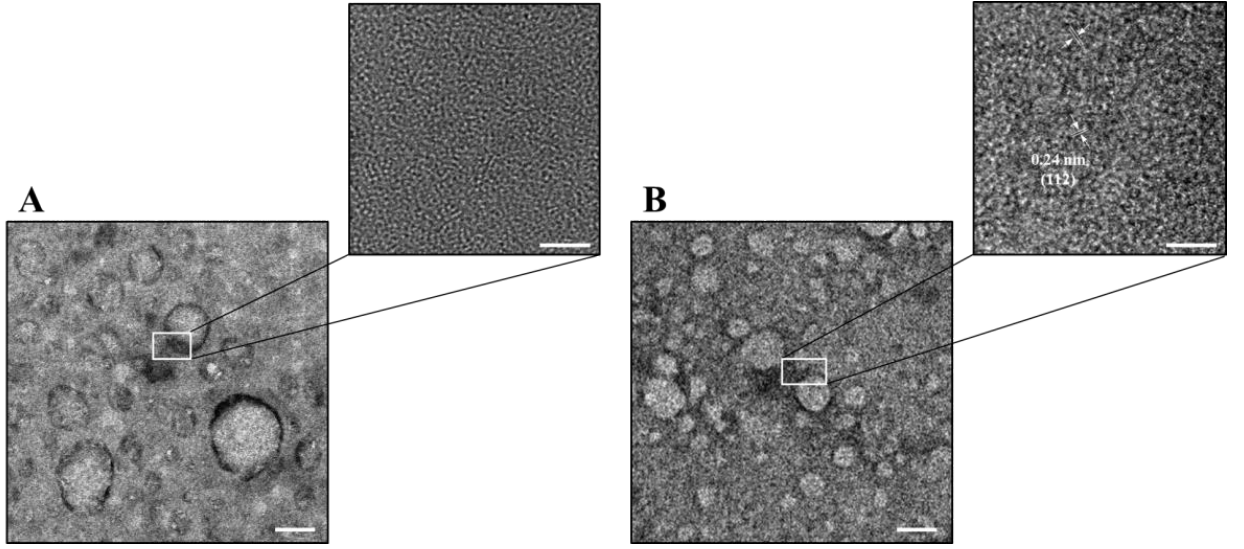
Figure 4. TEM and HRTEM images of IBV (5 × 10 5.25 CEID 50 mL – 1 ) ( A ) before and ( B ) after incubation with CNGs-270 (1.0 μg mL – 1 ) for 30 min in PBS. Scale bars in the TEM and HRTEM images are 100 and 5 nm, respectively. Table 1. CEID 50 mL – 1 and antiviral effect (%) of CNGs against IBV infection in the chicken embryo.